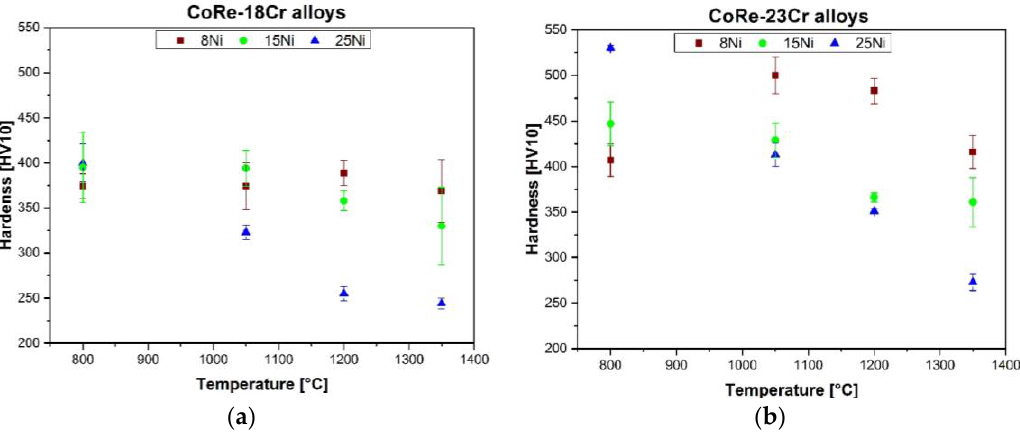
Figure 8. Hardness of the Co-Re-Cr-Ni alloys after heat treatment at different temperatures: ( a ) 18% Cr alloy; ( b ) 23% Cr alloys.